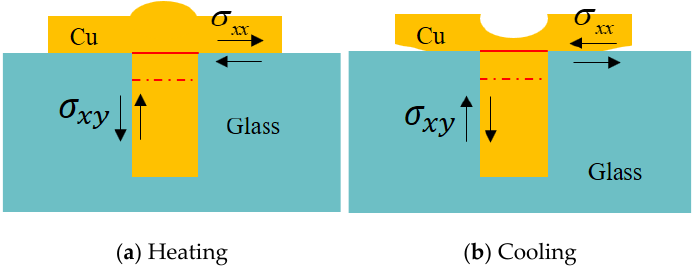
Figure 4. TGV delamination in the condition of opposing thermal stresses.